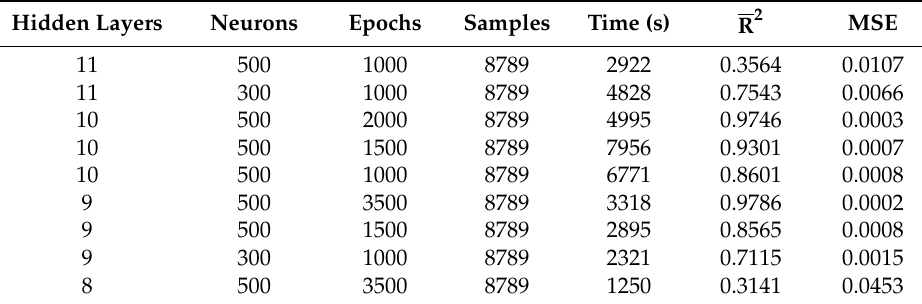
Table 2. Parameters and Results of Model I.